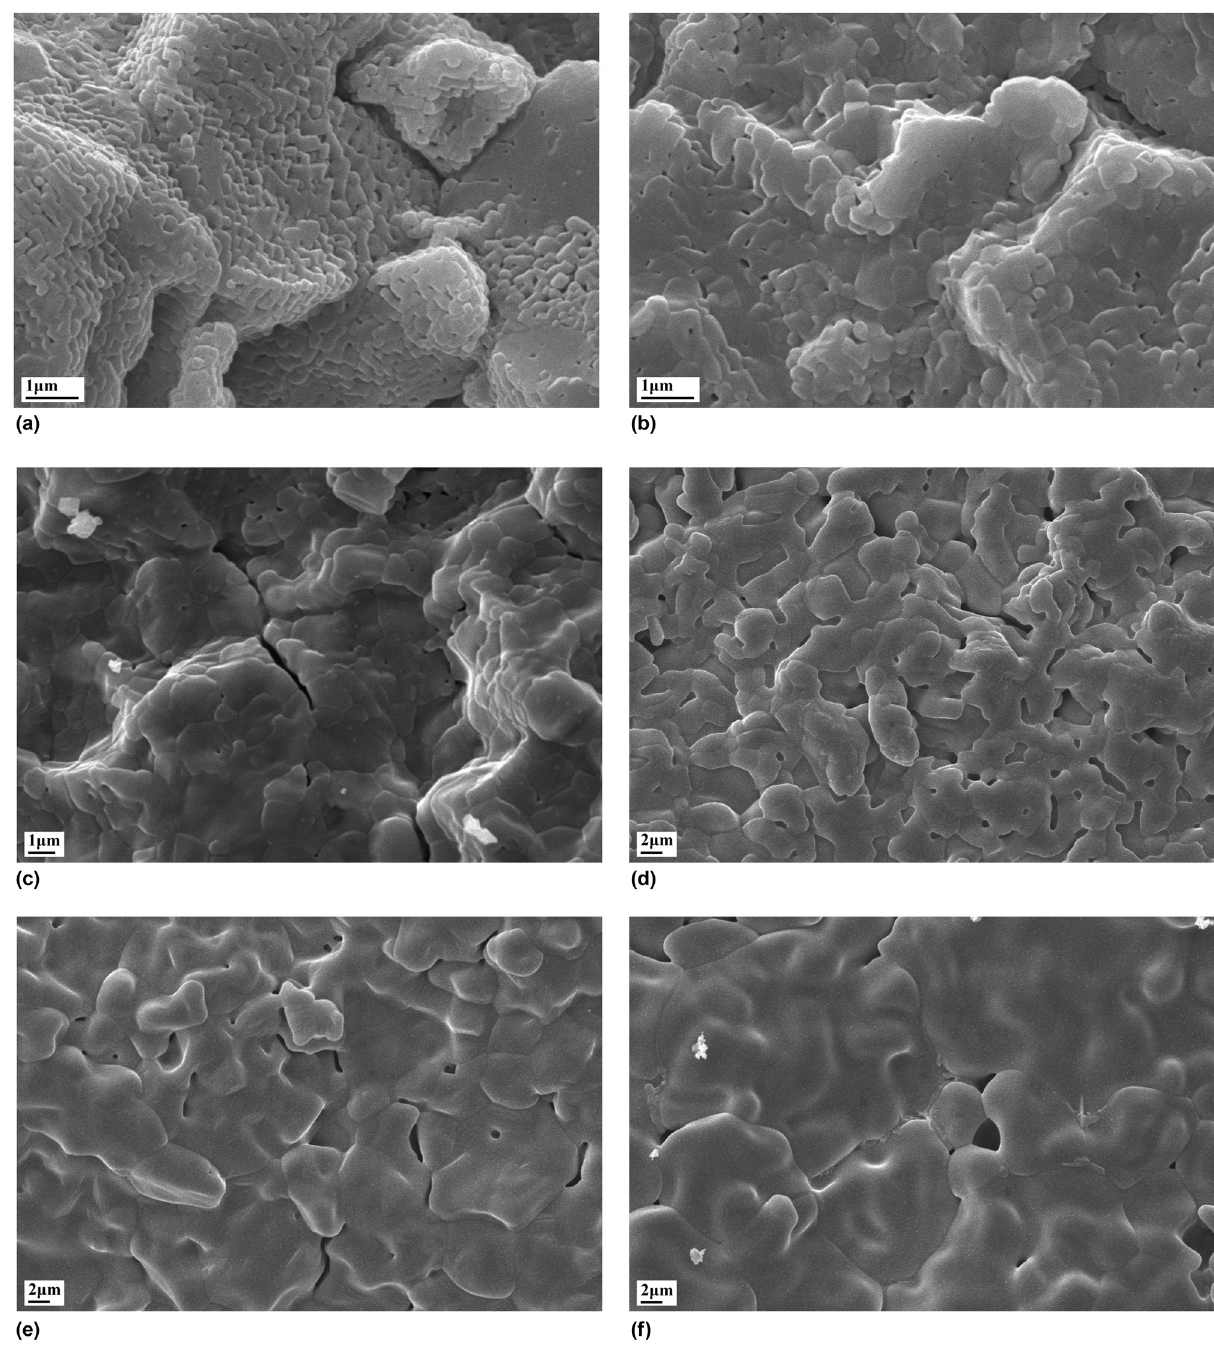
Figure 5: Microstructures of samples treated at di ff erent temperatures. ( a ) 1,350°C, 25 min; ( b ) 1,400°C, 25 min; ( c ) 1,450°C, 25 min; ( d ) 1,500°C, 25 min; ( e ) 1,550°C, 25 min; ( f ) 1,600°C, 25